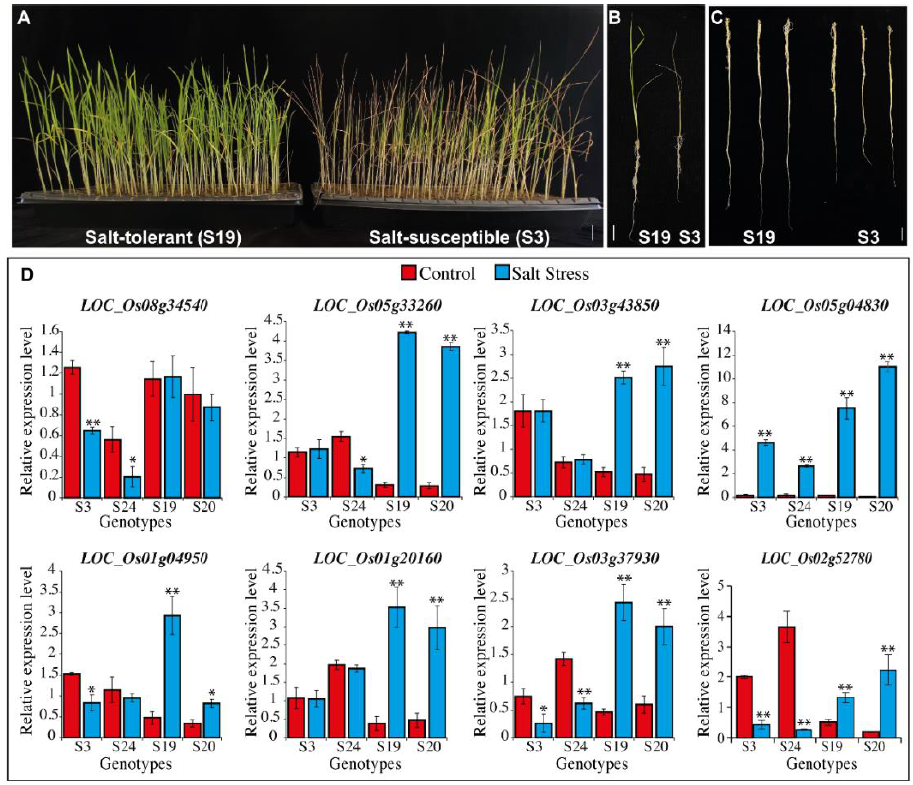
Figure 8. Physiological response of rice tolerant (“S19”) and susceptible (“S3”) genotypes in response to 200 mM salt stress. Comparison of S19 and S3 under salt stress ( A ), whole seedlings ( B ); and roots ( C ). Bars = 1 cm. ( D ) Quantification RT-PCR analysis of selected genes expression in salt-tolerant (“S19” and “S20”) and salt - susceptible (“S3” and “S24”) genotypes. OsActin1 was used for normalization. Bars showing the mean ± SD of three different experiments. t -test was used; ** p < 0.01, * p < 0.05.